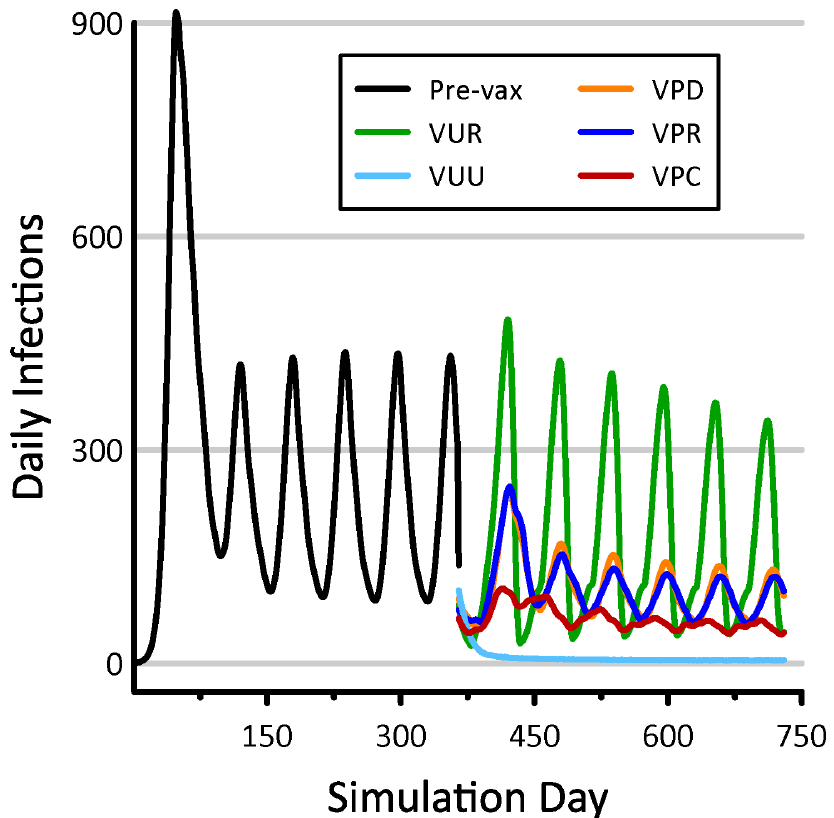
Figure 4. Daily infections resulting from five spatial vaccination strategies. Numbers of infections prior to vaccination are shown in black. These models all incorporate social distancing, and the results shown are mean values taken from 10 replicate simulations.